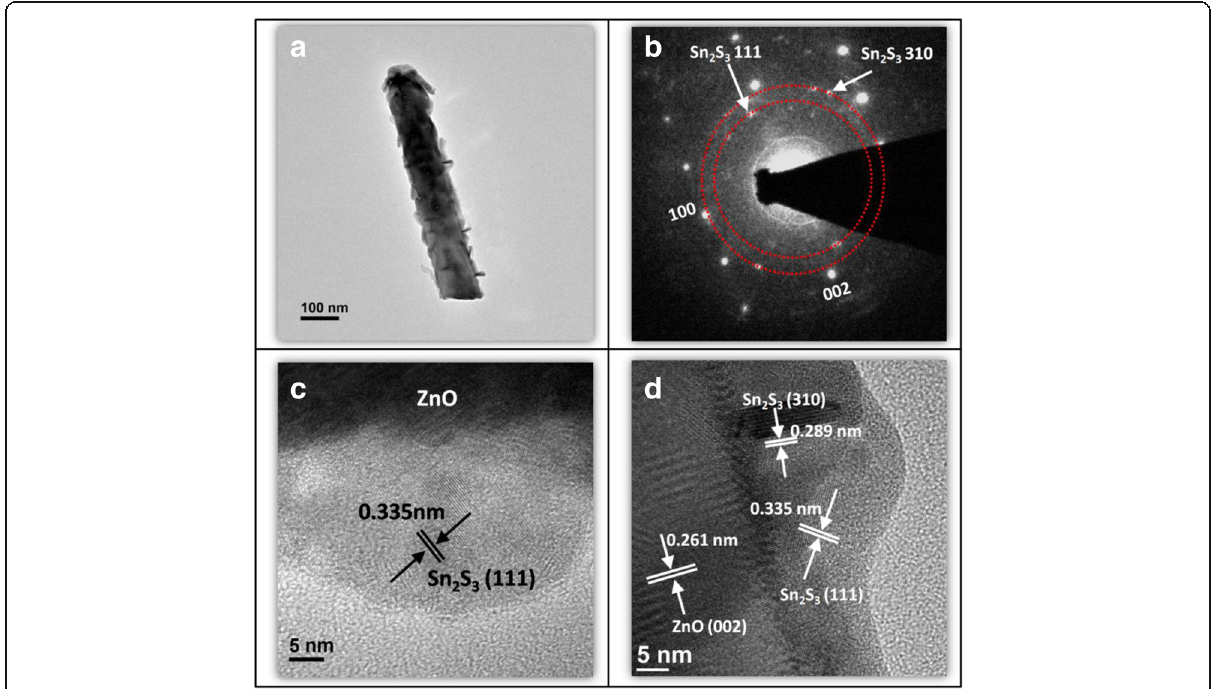
Fig. 3 TEM analyses of the ZnO – Sn 2 S 3 nanorod heterostructure. a Low-magnification TEM image of the ZnO – Sn 2 S 3 nanorod. b SAED pattern of the nanorod. c , d HRTEM images taken from the local regions of the